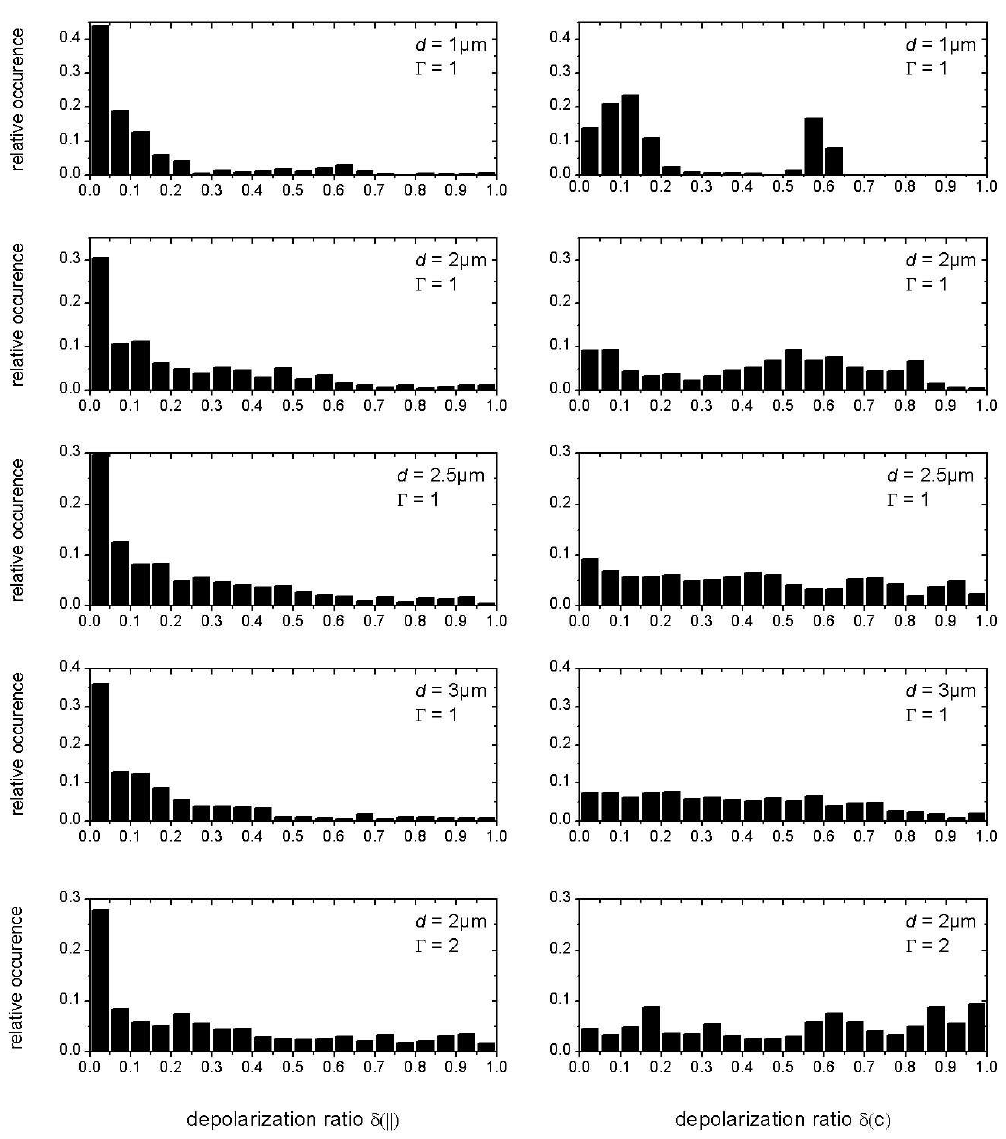
Fig. 2. Occurrence of the depolarization ratio δ || (left panels) and δ C (right panels) considering particles diameters of 1, 2, 2.5 and 3µm and aspect ratios 0 of 1 and